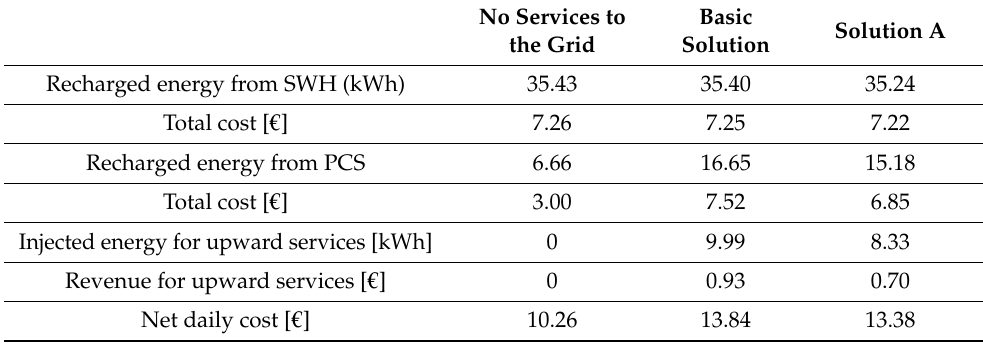
No Services to Basic Solution A the Grid Solution